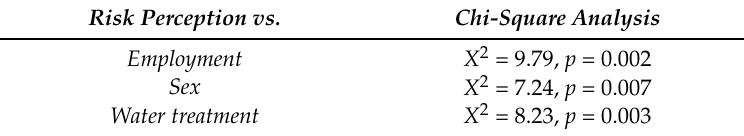
Table 4. Significant chi-squared results for relationships associated with risk perception. Risk Perception